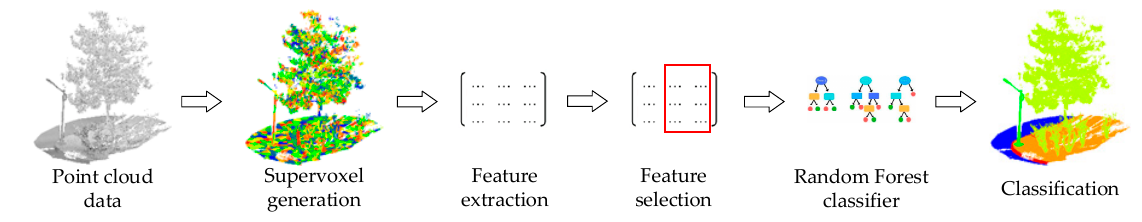
Figure 1. The general framework of this study.